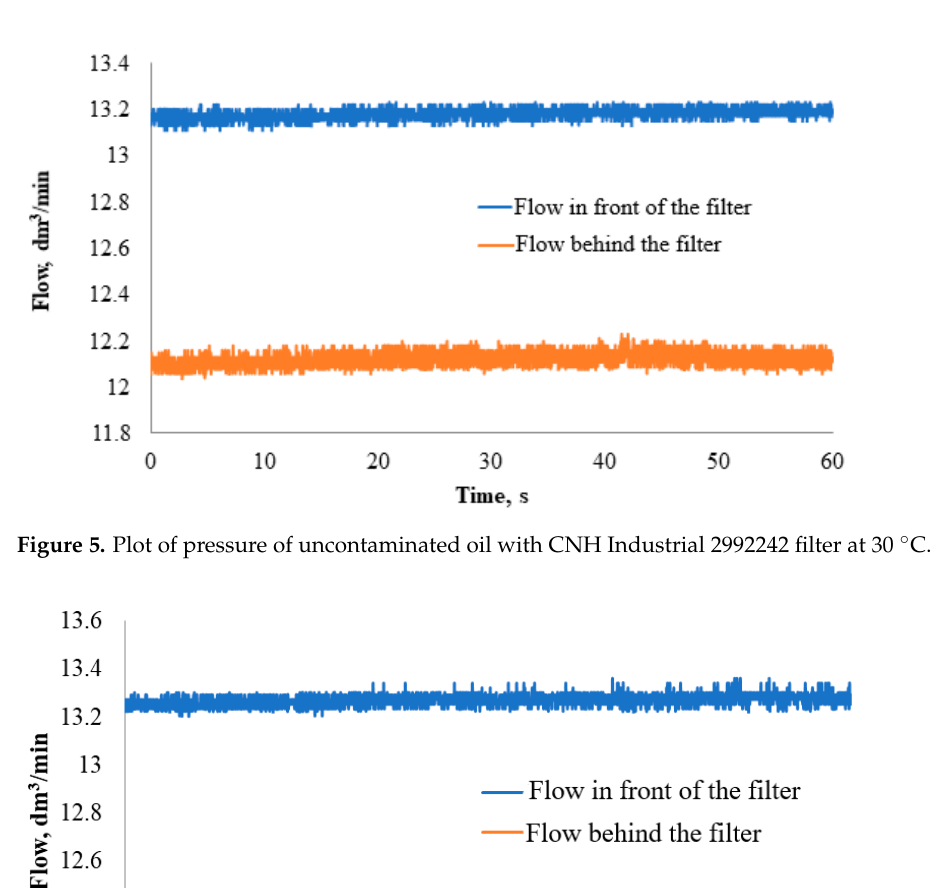
Figure 6. Plot of flow of uncontaminated oil with CNH Industrial 2992242 filter at 30 °C.